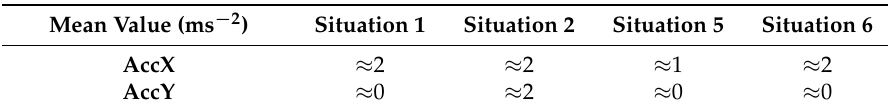
Table 1. Approximation of the mean values of the head accelerations according the mediolateral (X) and the anteroposterior (Y).